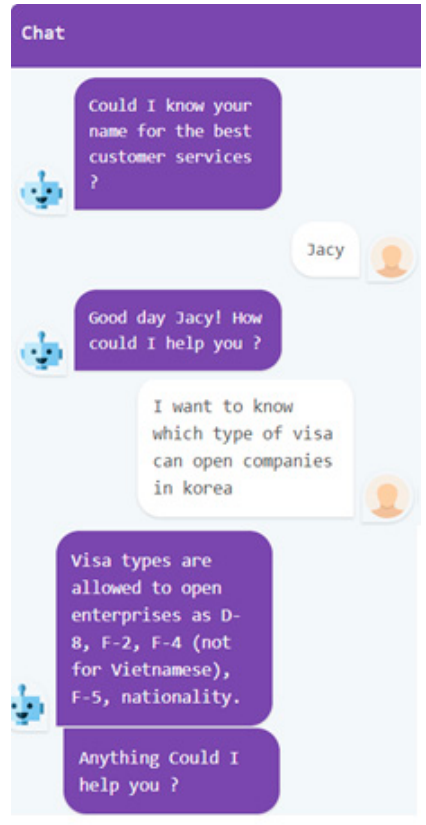
Figure 26. Assistant Application providing legal information.